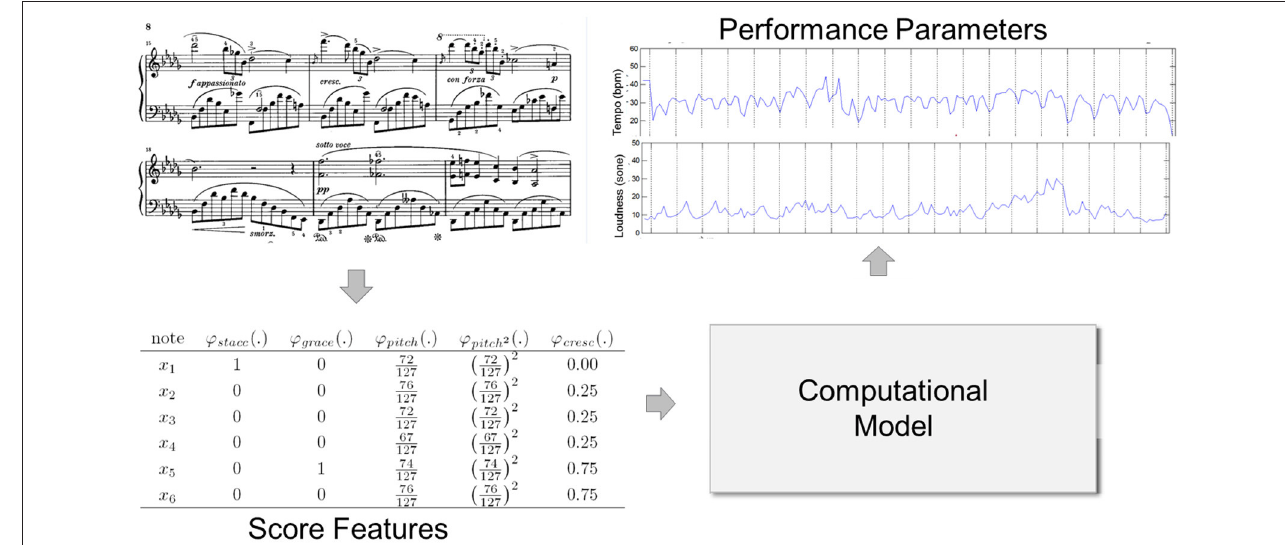
FIGURE 1 | Computational modeling